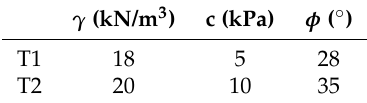
Table 1. Deterministic properties for soil cover before (T1) and after (T2) stabilization